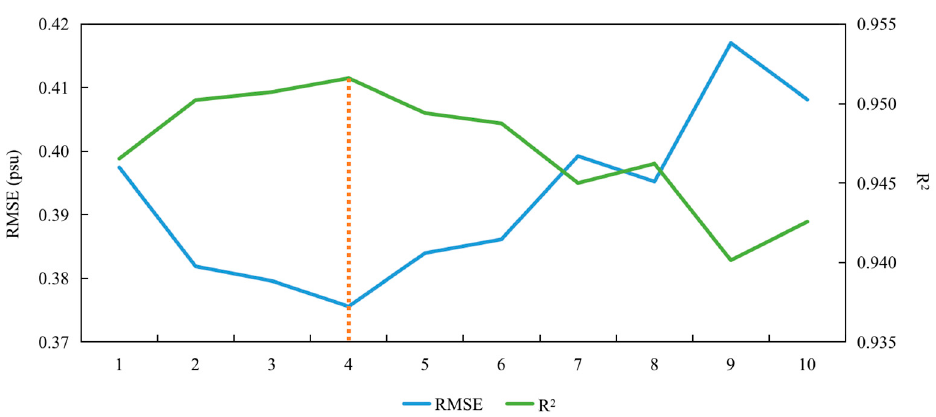
Figure 3. Trend in the RMSE and R 2 when evaluating SSS accuracy and interpretability as rule number increases.